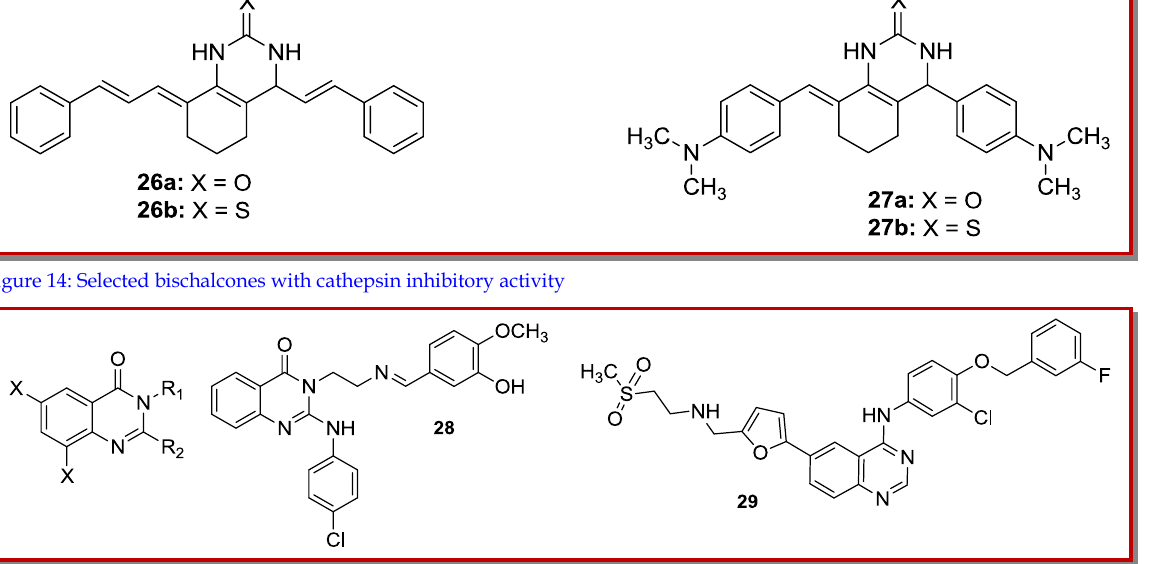
Figure 15: Selected quinazoline motifs with antibacterial